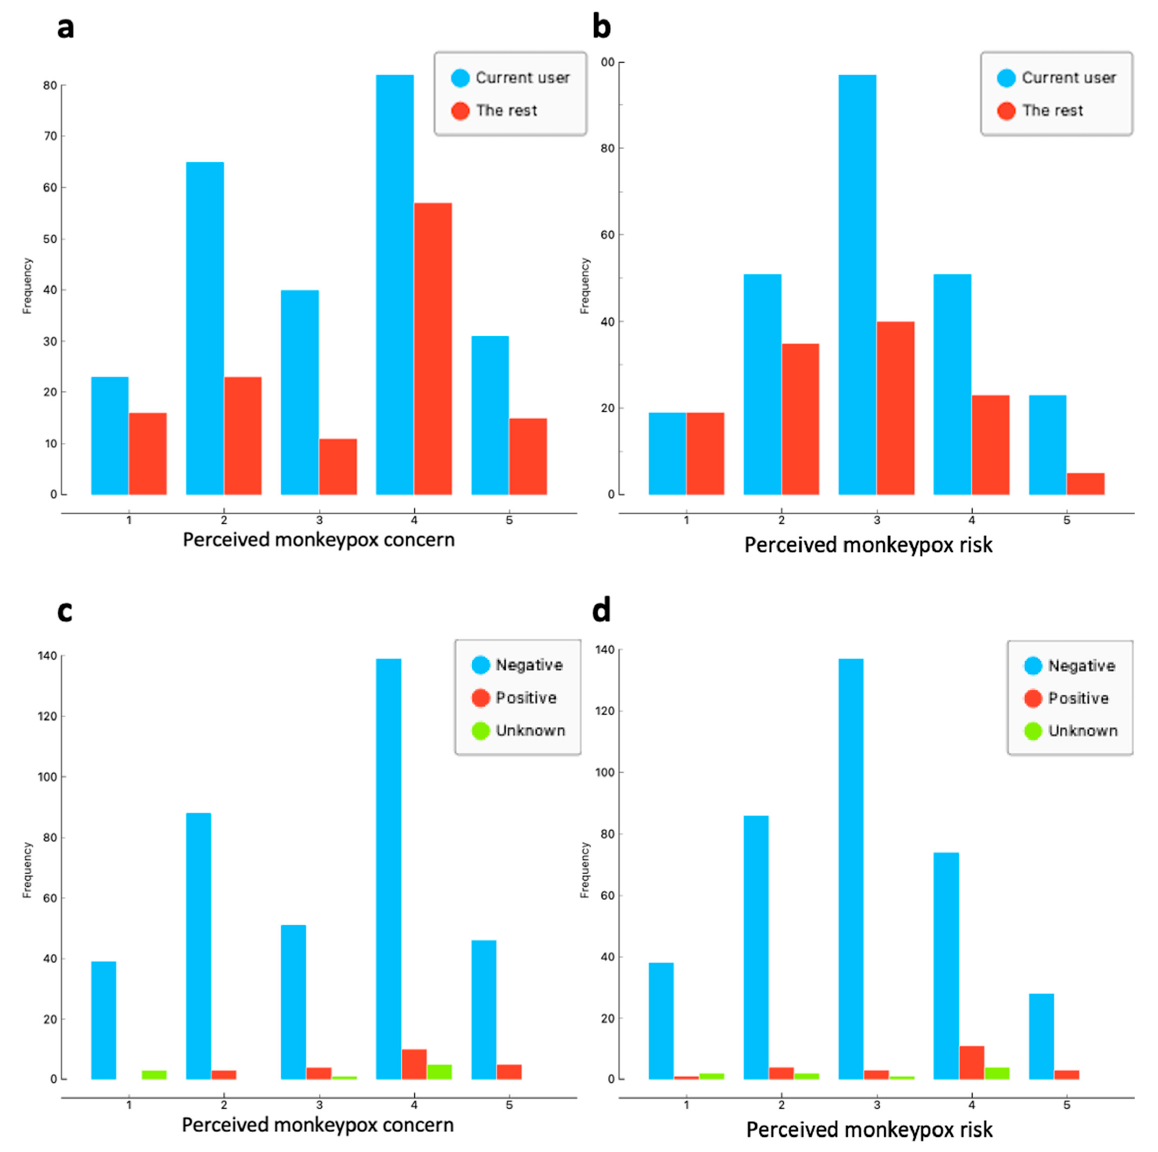
Figure 1. Distribution of ( a ) perceived monkeypox concern by PrEP-use status, ( b ) perceived mon- keypox risk among MSM by PrEP-use status, ( c ) perceived monkeypox concern by HIV status and ( d ) perceived monkeypox risk among MSM by HIV status. Note: two endpoints were measured on a 1–5 Likert scale (with 1 = “Very low” and 5 = “Very high”).